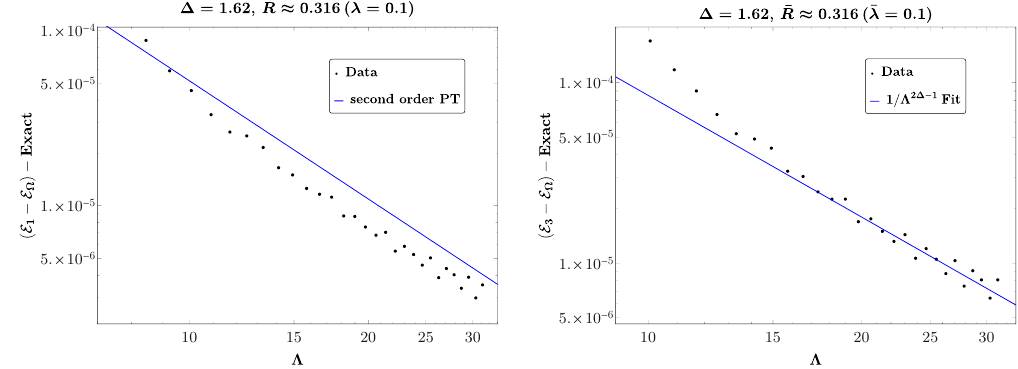
Figure 9. Log–log plot of Hamiltonian truncation deviation from the exact value as a function of the cutoff Λ for coupling ¯ λ = 0 . 1 . The left plot shows the convergence for the first excited state with the blue line equal to − ¯ λ 2 0 . 898 extracted from eq. (4.22). The right plot shows the convergence for Λ 2 . 24 the third excited state corresponding to a state with two particles at rest. The blue line is a single parameter fit a Λ 2 . 24